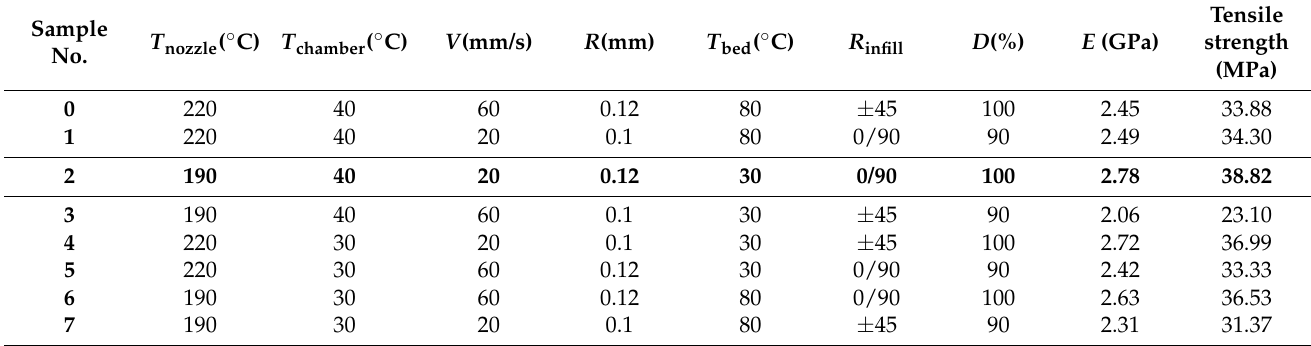
Table 2. Key printing parameters and their effect on the E and the σ of compact PLA specimens.